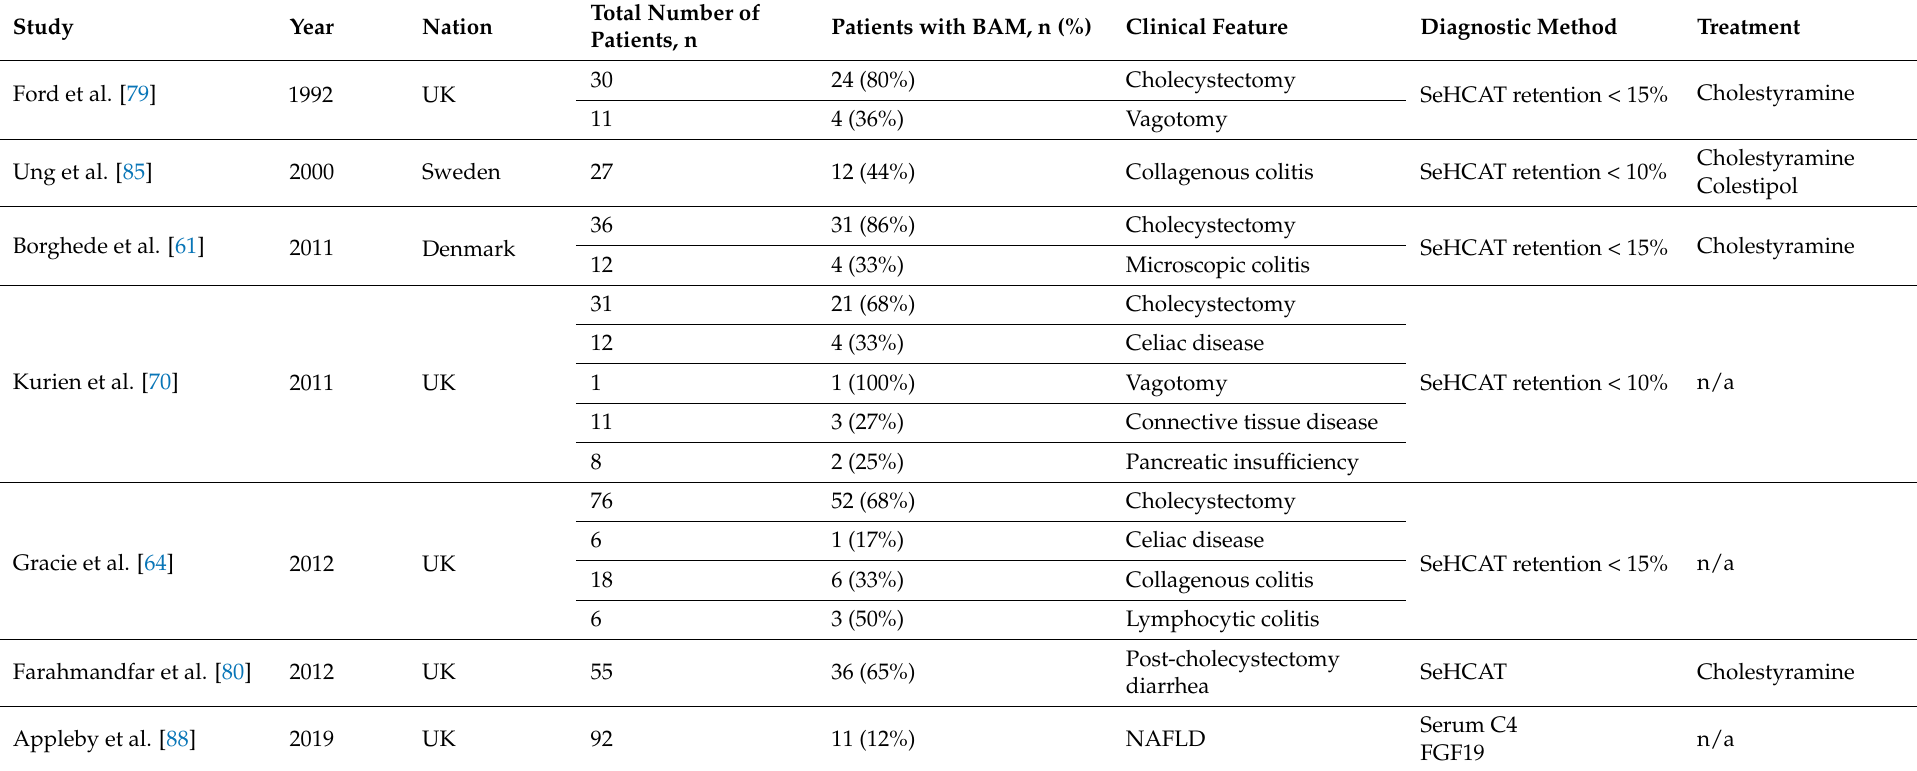
Table 3. Studies investigating the prevalence of bile acid malabsorption type